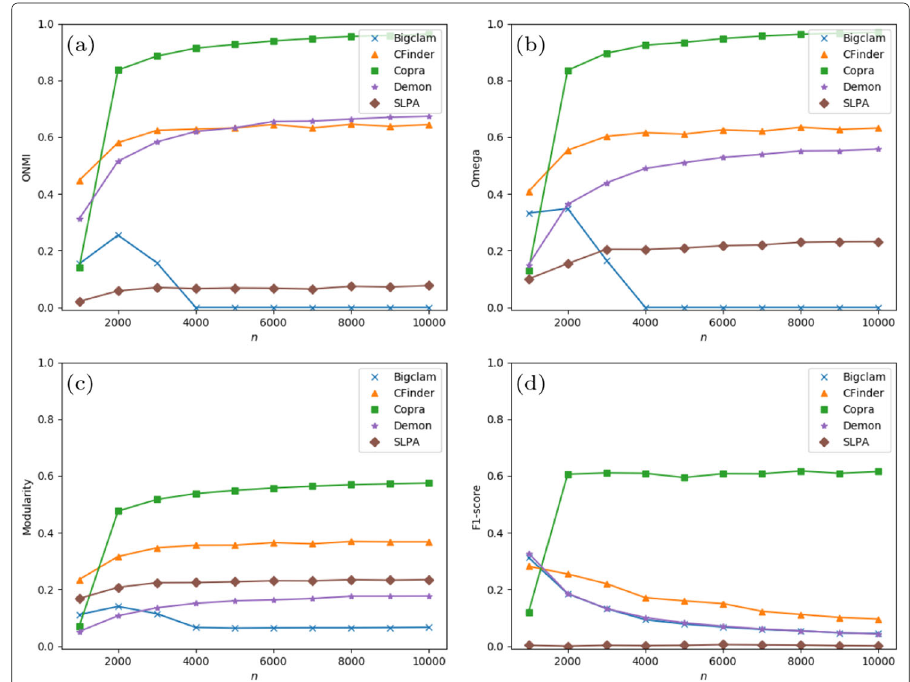
Fig. 9 Variation of the number of nodes ( n ) for LFR synthetic networks considering: a ONMI; b Omega; c Modularity and d F1-score